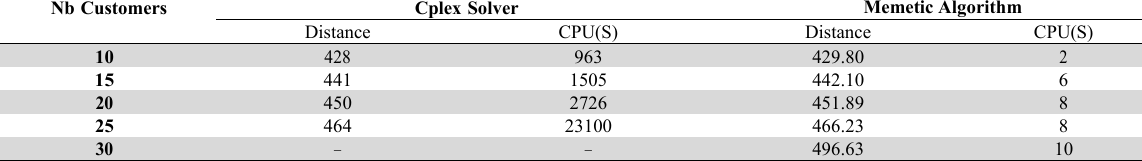
Comparison of Cplex and Memetic algorithm results for Static VRPSDP Nb Customers